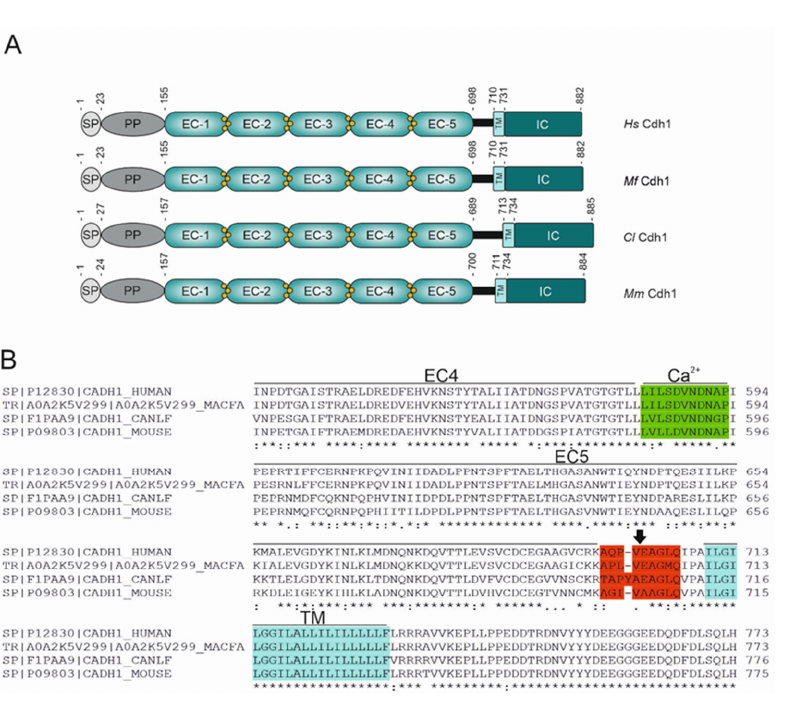
Figure 1. Cdh1 orthologues share high sequence homologies in HtrA cleavage sites. ( A ) Models of the domain structure of the Cdh1 expressed by Homo sapiens (Hs) , Macaca fascicularis (Mf), Canis lupus familiaris (Cl) and Mus musculus (Mm) . Calcium binding regions are located in between the EC domains with calcium ions shown as yellow spheres. SP, signal peptide; PP, pro-peptide; EC, extracellular domain; TM, transmembrane domain; IC, intracellular domain. ( B ) Alignment of the amino acid sequence of Cdh1 orthologues spanning the region between the EC4, HtrA signature sites (highlighted in green), EC5, linker region (highlighted in red), identified HtrA cleavage site (black arrow), and the TM domain (highlighted in